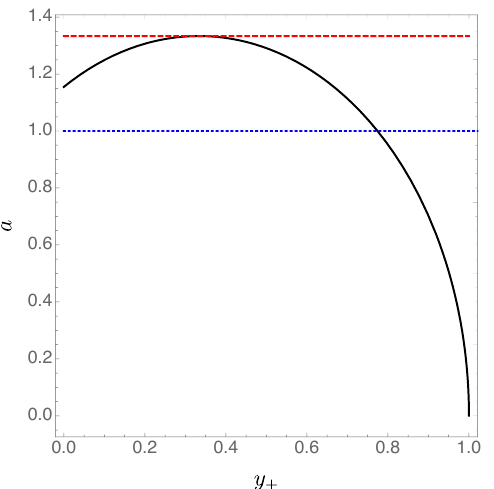
Figure 1 . a as a function of y + : the horizontal red dashed like corresponds to a = a max = 4 = 3 and the vertical blue dotted line to a = 1, beyond which g tt becomes everywhere spacelike at the